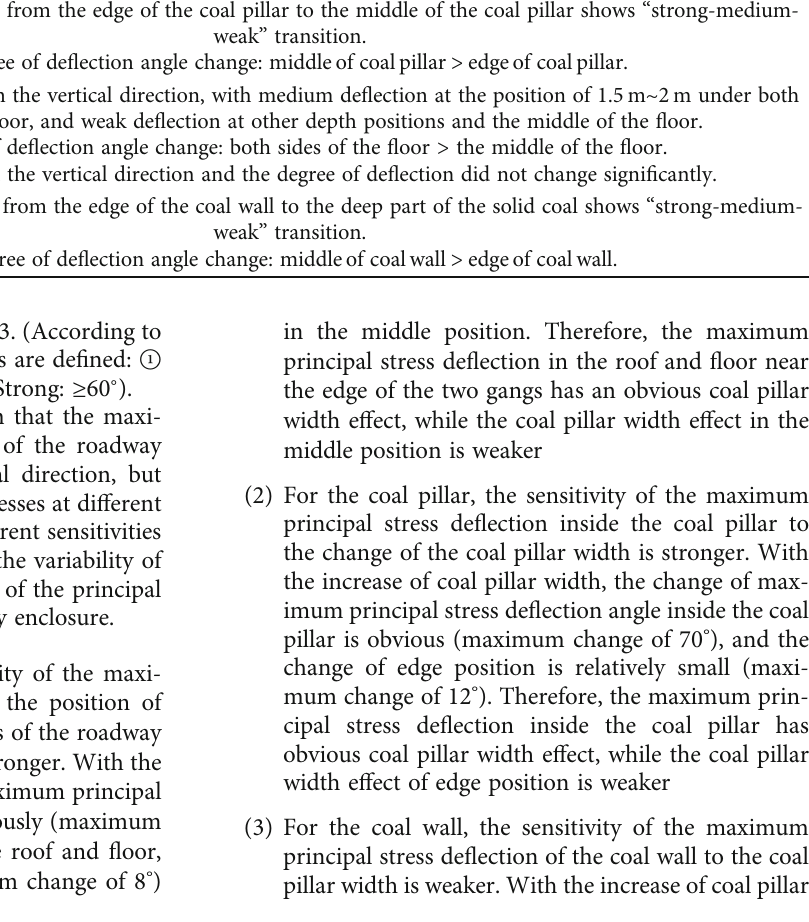
De fl ection pattern